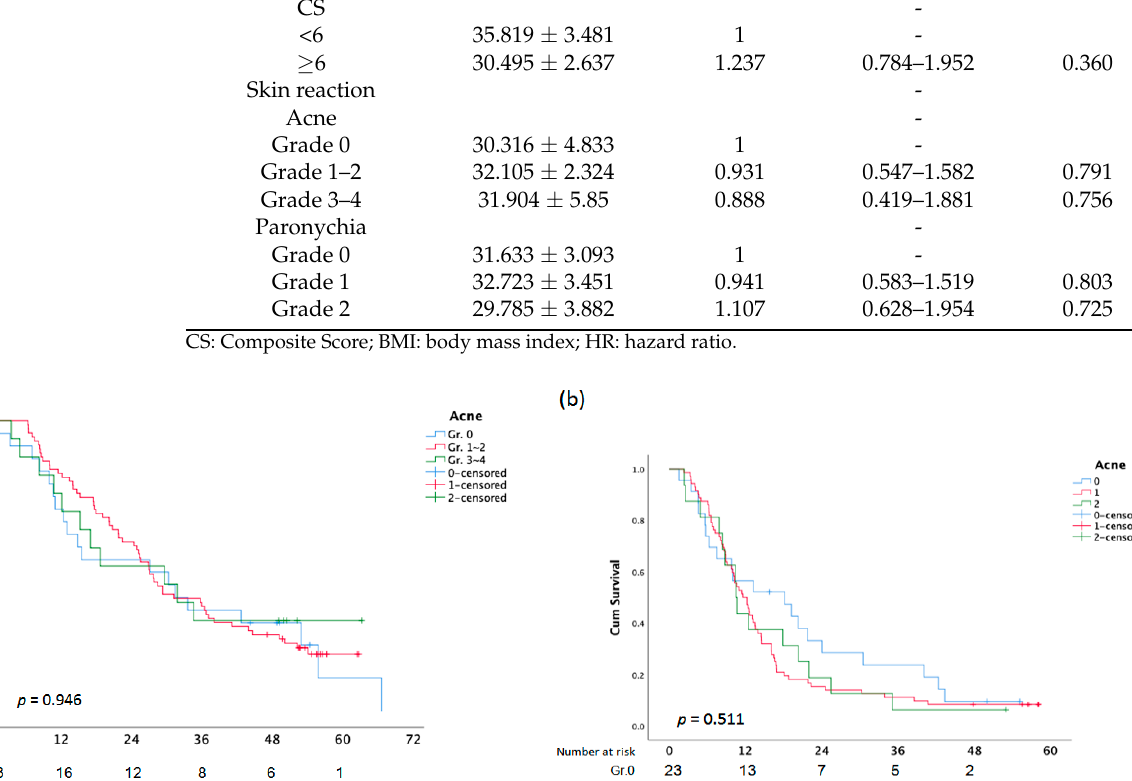
Figure 2. Overall Survival ( a )and PFS ( b ) analysis according to Paronychia. There was no statistically significant difference between OS and PFS and the assess- ment of the EGFR composite score, skin responses, and paronychia (Figure 3). ( a ) ( b ) Figure 3. Overall Survival ( a ) and PFS ( b ) analysis according to Composite Score. Table 5. Association of clinical variables and skin reactions with median Progression Free Survival by univariate analysis (N = 111).